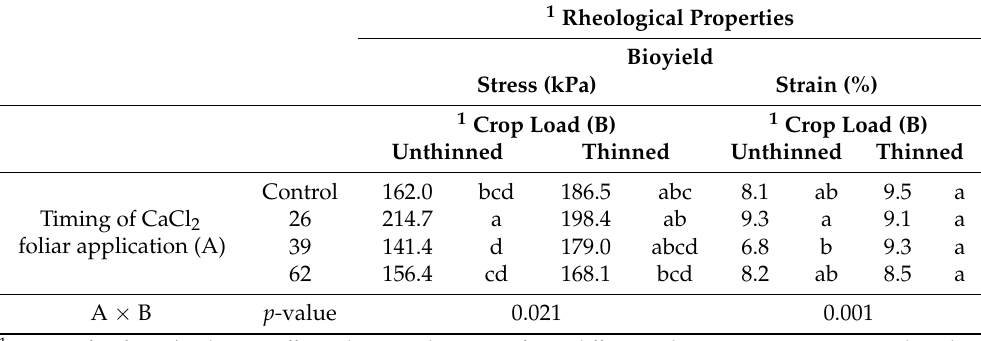
Table 7. Interaction between the timing of foliar CaCl 2 applications (i.e., Control, and 26, 39, or 62 days after full bloom, DAFB) and crop load (i.e., natural crop load without fruit thinning vs. 50% of fruit removal 31 DAFB) on the rheological properties in the sweet cherry combination